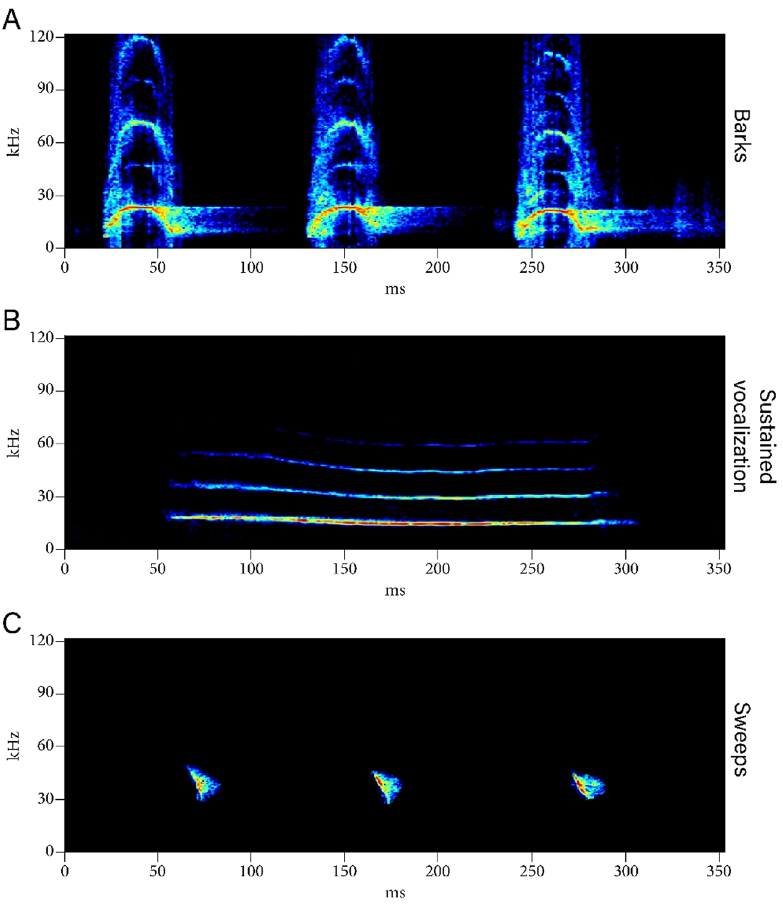
Figure 1. California mouse vocalizations. Examples of ( A ) Barks, ( B ). A sustained vocalization (SV), and ( C )